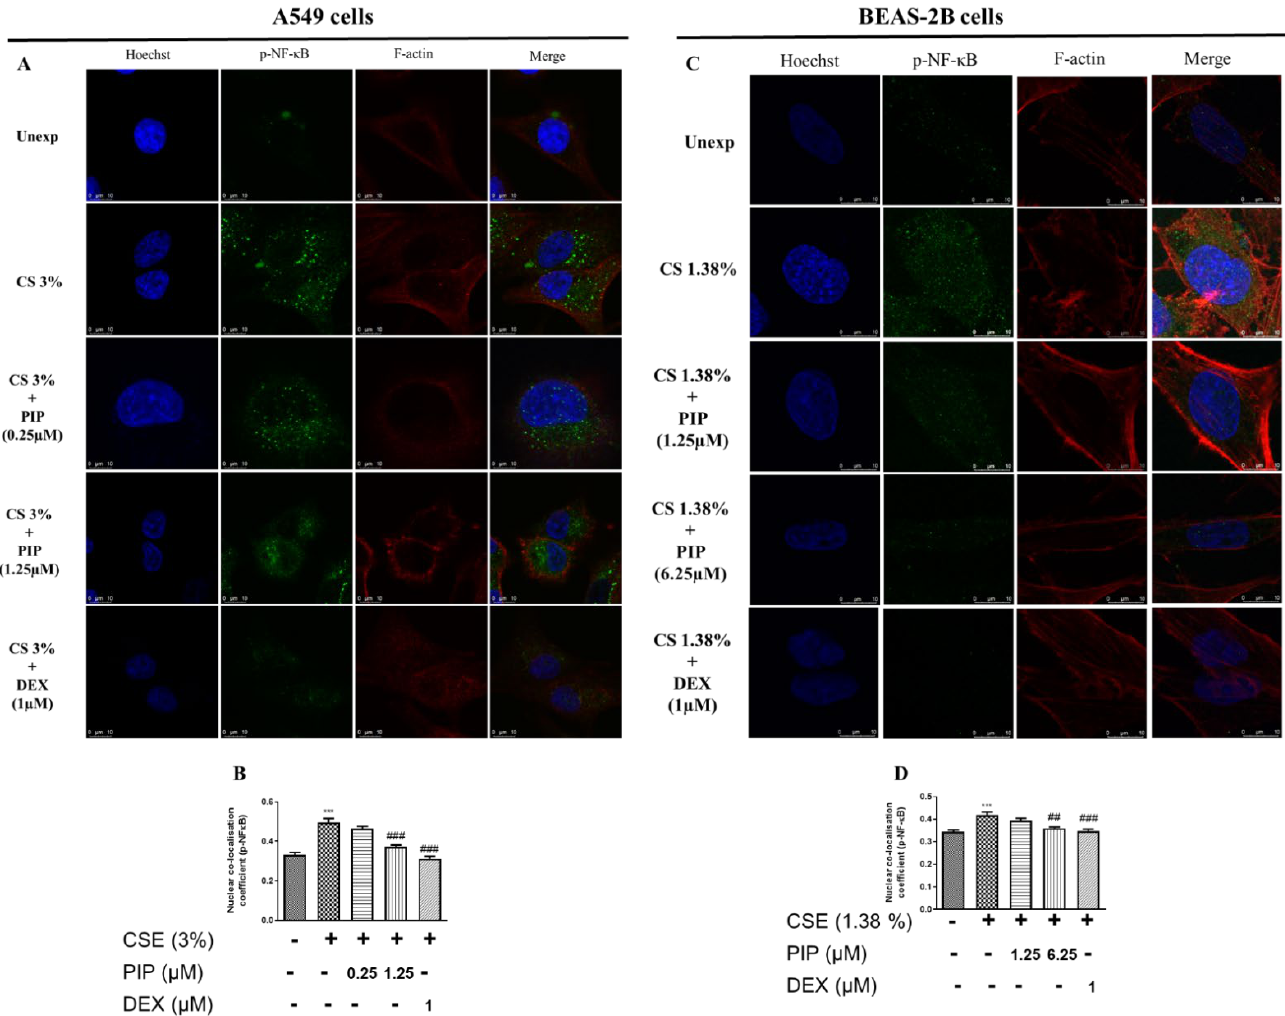
Figure 3. Effect of piperine treatment on expression of NF- κ B signaling in CSE exposed airway cells. ( A ) Immunofluorescence staining assay representing an expression of p-NF- κ B in A549 cells. Bar graphs representing a mean fluorescence intensity of ( B ) p-NF- κ B. ( C ) Immunofluorescence staining assay representing an expression of p-NF- κ B in BEAS-2B cells. Bar graphs representing a mean fluorescence intensity of ( D ) p-NF- κ B. The values are expressed as mean ± SEM ( n = 3). Blue colour indicates nuclei, green colour represents p-NF- κ B protein expression, and red colour represents F-actin labelled with phalloidin red. *** p < 0.001 vs. Unexposed, ## p < 0.01 and ### p <0.001 vs. CSE. For A549 cells: CSE: cigarette smoke extract-treated (3%), CS + PIP (0.25): cigarette smoke extract + 0.25 µ M PIP, CS + PIP (1.25): cigarette smoke extract + 1.25 µ M PIP, CS + DEX (1): cigarette smoke extract + 1 µ M DEX. For BEAS-2B cells: CSE: cigarette smoke extract-treated (1.38%), CS + PIP (1.25): cigarette smoke extract + 1.25 µ M PIP, CS + PIP (6.25): cigarette smoke extract + 6.25 µ M PIP, CS + DEX (1): cigarette smoke extract + 1 µ M